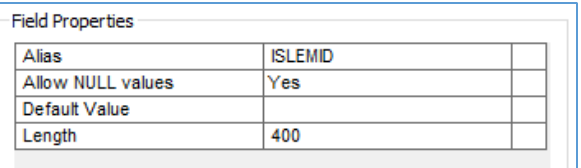
Figure 4. ISLEMID field